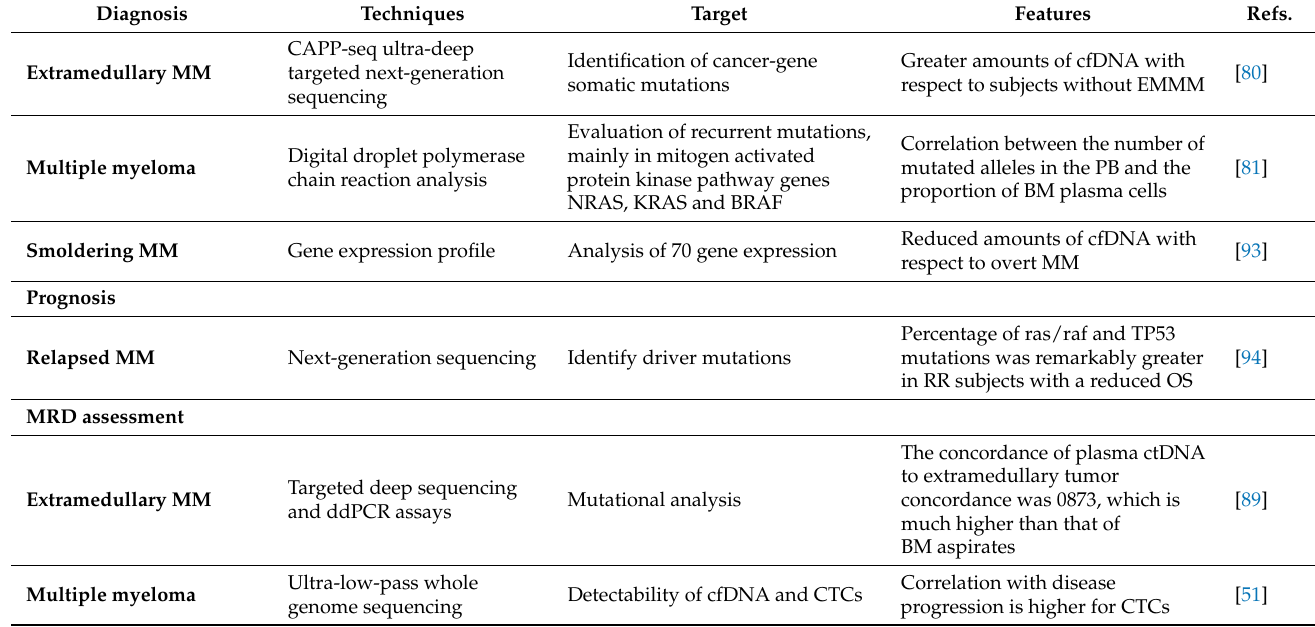
Table 2. Diagnostic and prognostic value of cfDNA in multiple